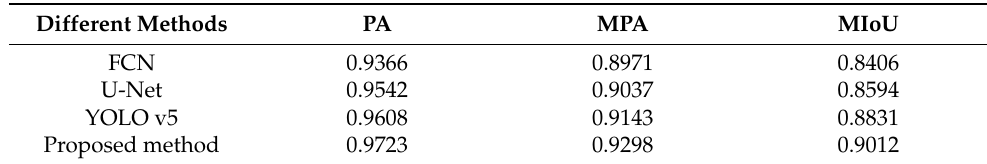
Table 4. Recognition accuracy of the four different